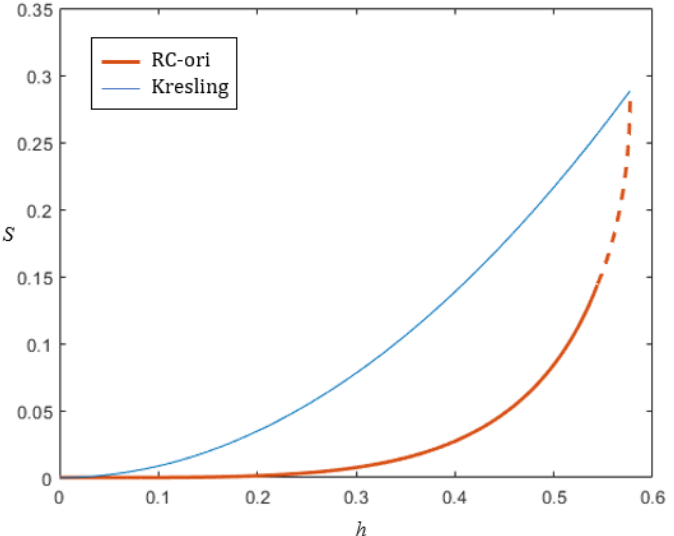
Figure 15. Comparison of the relationship between S and h of the RC-ori structure and the Kresling structure. ( n =